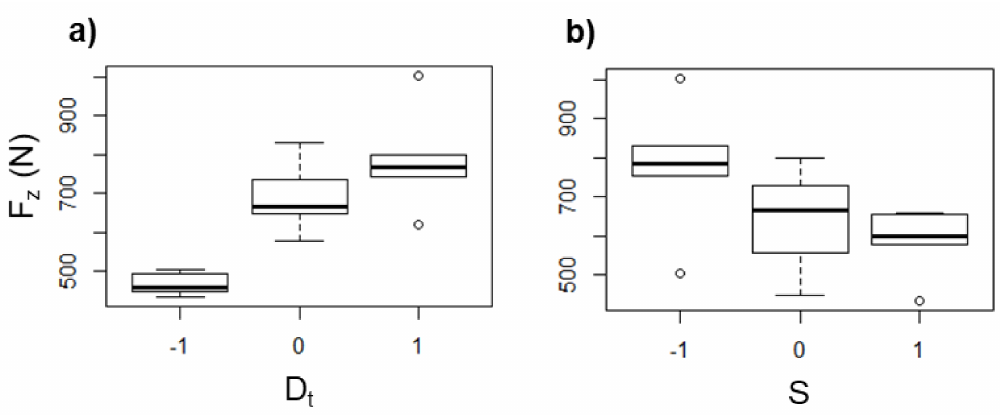
Figure 14. Box diagrams of T max (in ◦ C) for UHMWPE as a function of ( a ) D t and ( b ) S